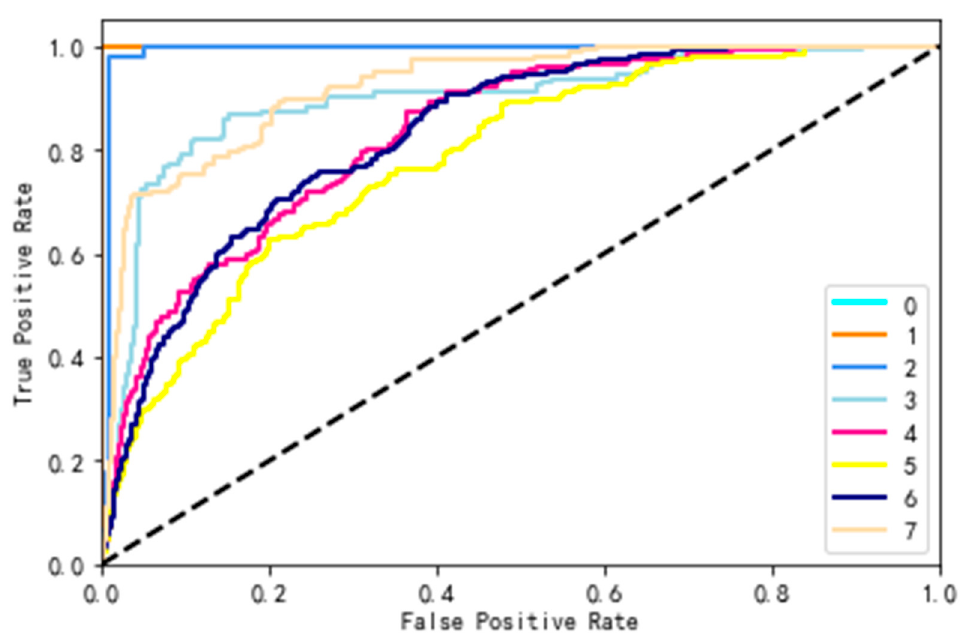
Figure 14. Sydney_Opera_House receiver operating characteristic curve.